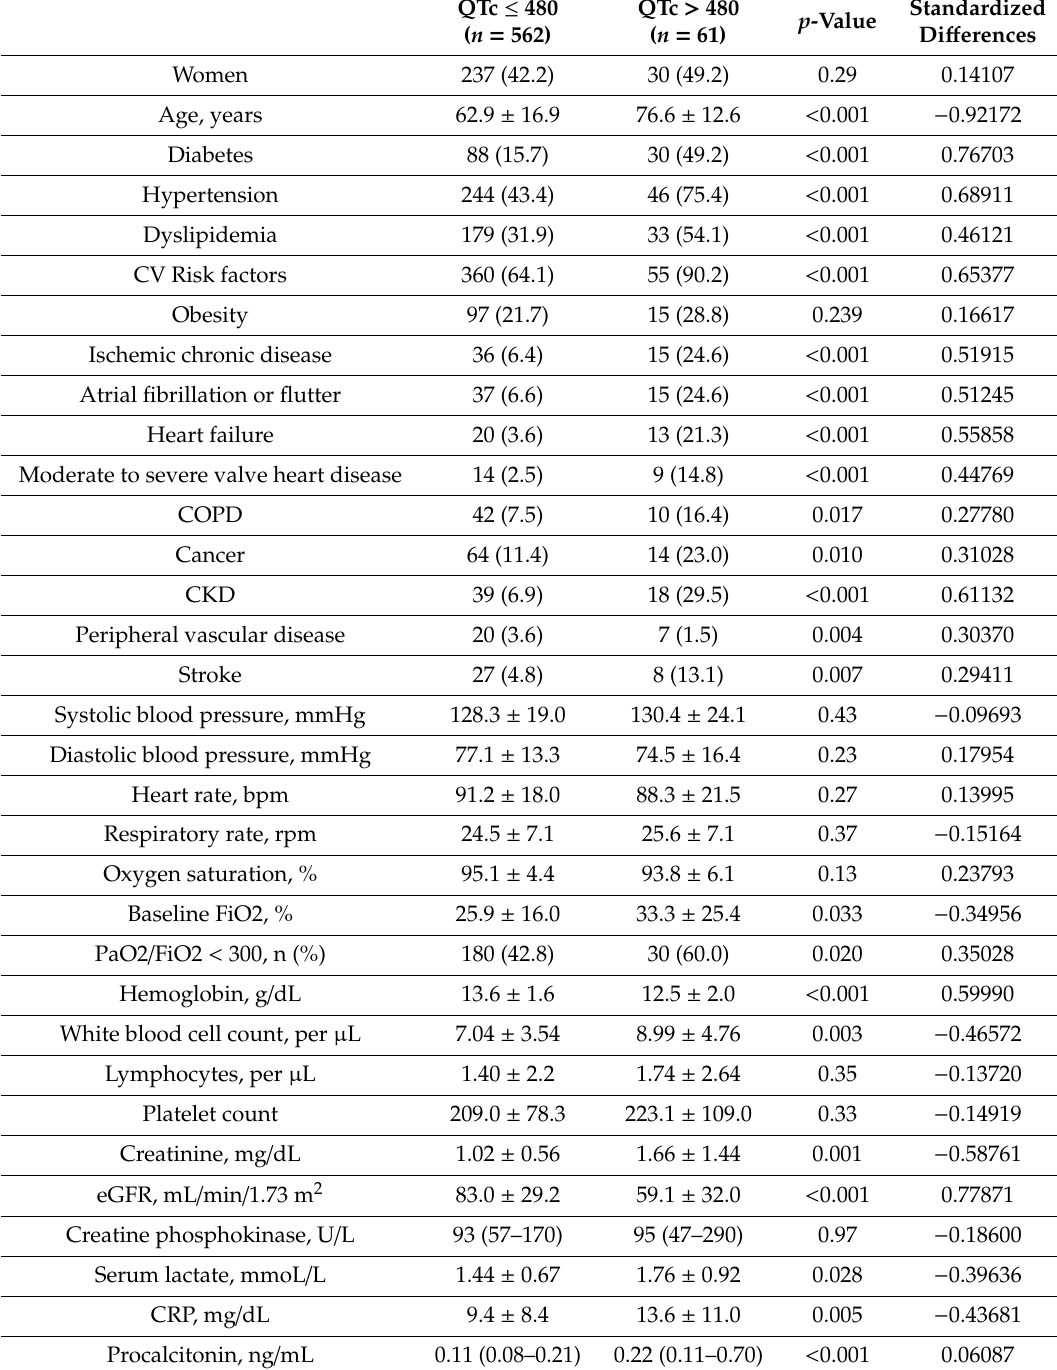
Table 1. Comparison of baseline characteristics and clinical presentation between patients with and without prolonged QTc on